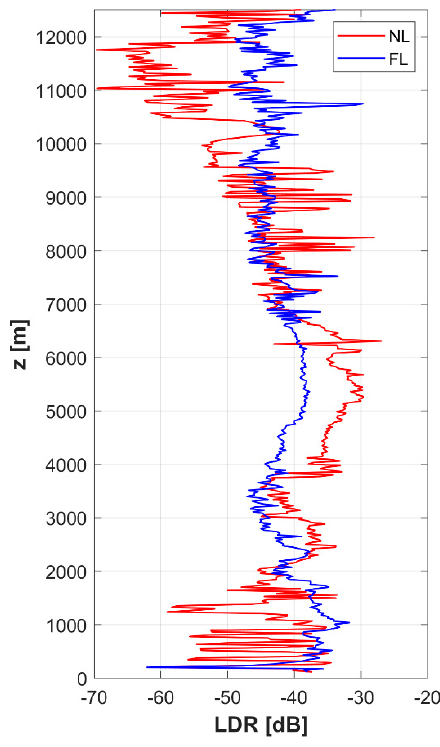
Figure 10. Vertical profile of mean LDR during thunderstorms observed at the Milešovka observatory for NL (red curve) as compared to FL (blue curve). Y-axis represents the height [m] above the cloud radar situated at an elevation of 837 m a.s.l.